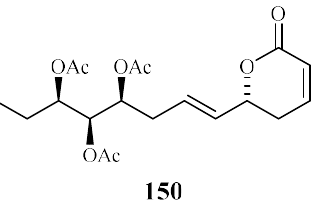
Figure 34. Compound from a Verbenaceae plant.